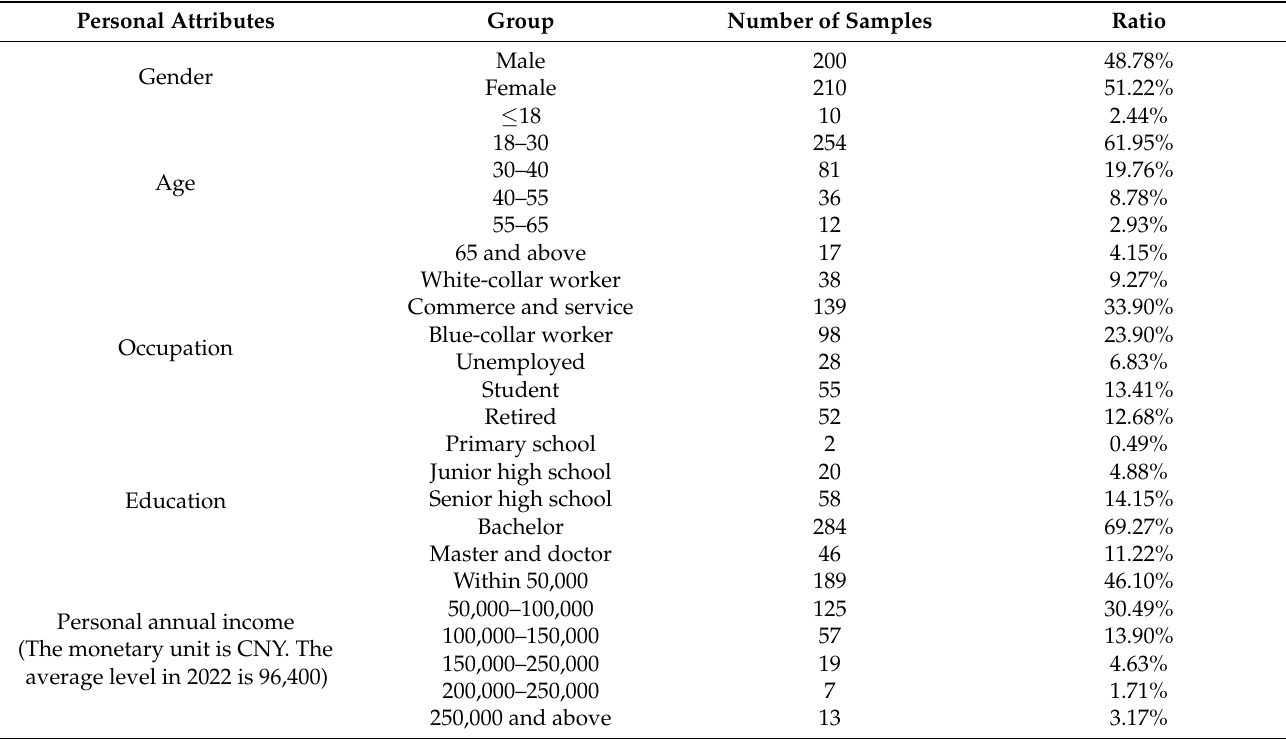
Figure 3. Research area and sample distribution. Table 3. Statistical description of personal attributes.